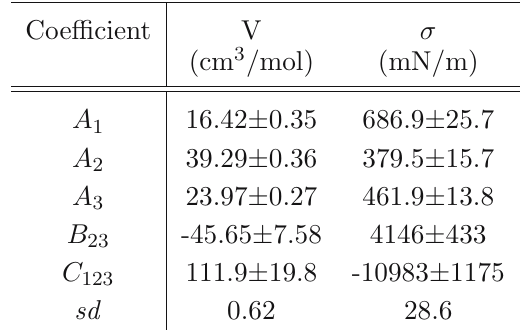
, B , C , and the standard deviations of approximation of the i ij ijk